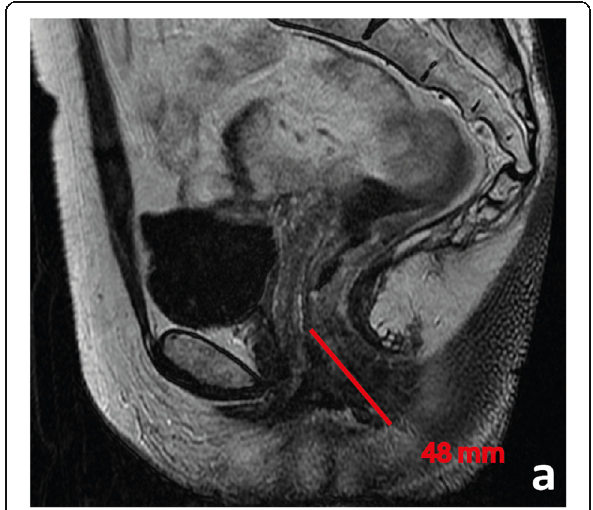
Fig. 19 A low rectal cancer is depicted with its lower edge 48 mm above the anal verge. Measurement is made from the central axis of the anus to the central axis of the rectum at the plane of the lower edge of the